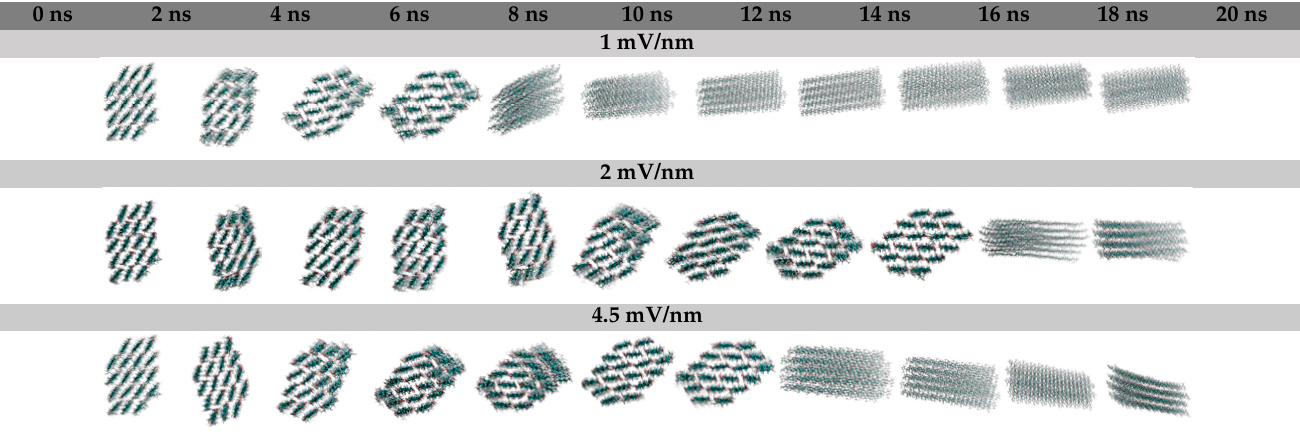
Figure 6. Setup of high electric field strength applied along the x-axis: the angle θ shows the tilt reference used for the analysis. Table 3. Snapshots of CNF alignment and the applied external electric fields in the